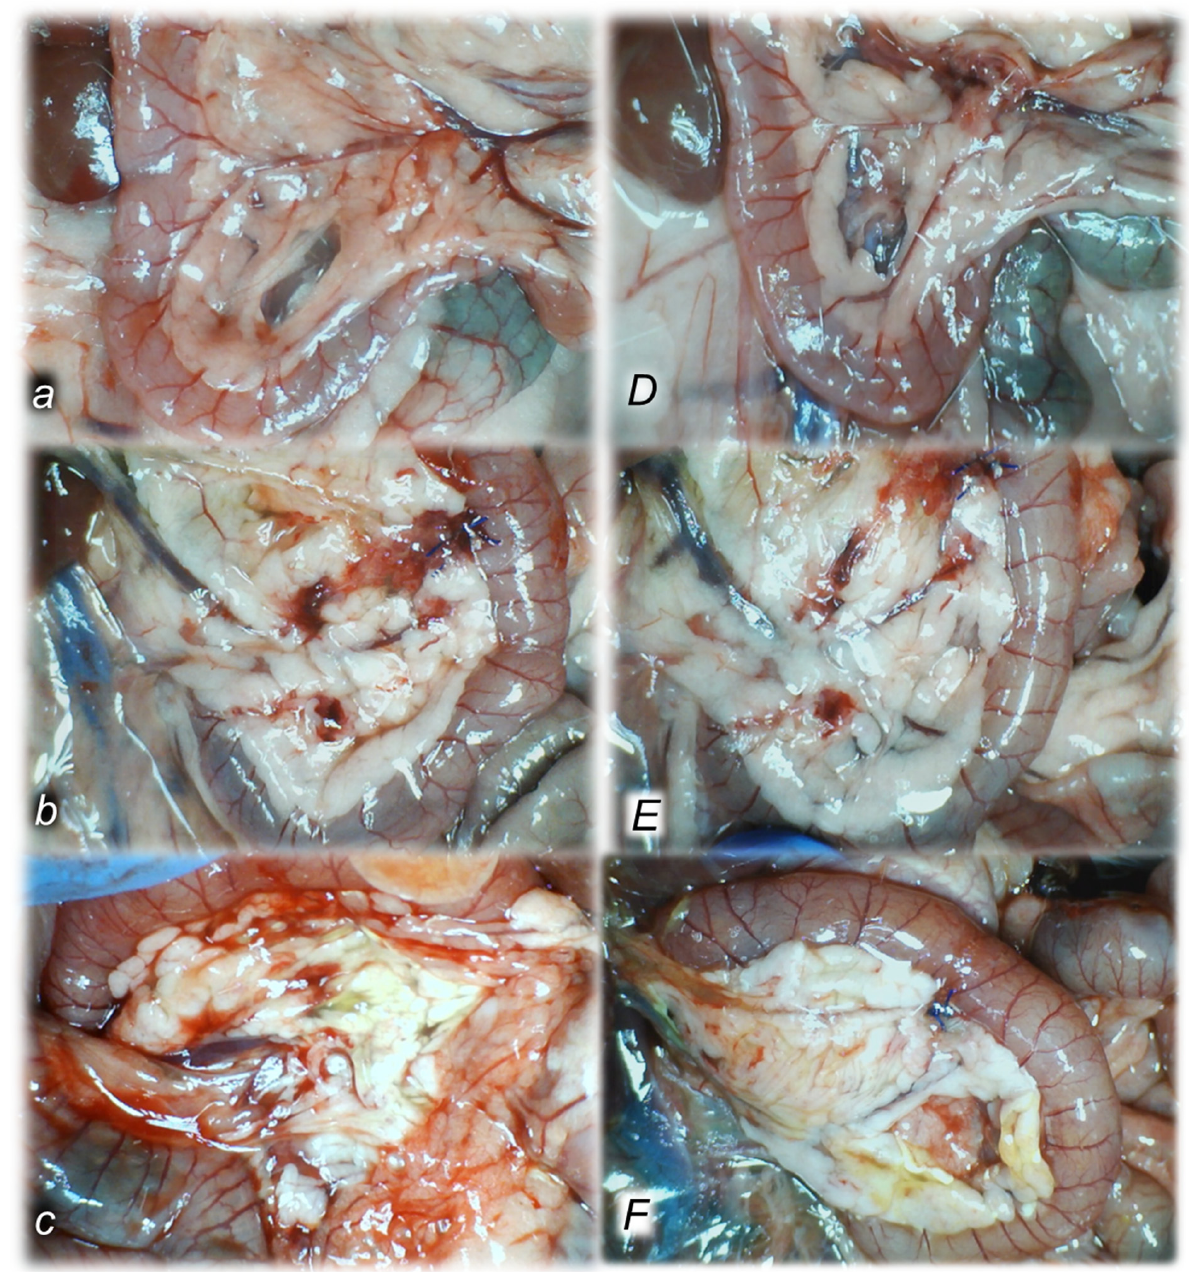
Figure 5. Regular timeline (30 min ( a , D ), 5 h ( b , E ) and 24 h ( c , F ) ligation time period) of disturbed pancreas presentation in controls ( a – c ). Upon BPC 157 therapy and recruitment of the defensive pathways, pancreas swelling and lesions ( D – F ) at 30 min ( D ), 5 h ( E ) and 24 h ( F ) ligation time period were counteracted. Illustrative recovered presentation included BPC 157 (10 ng/kg) or saline (5 mL/kg) as an intragastric administration, either immediately following ligation, as an early regimen (0–30 min ( D ), 0–24 h ( F )), or as delayed regimen (4.30 h–5 h ( E ) application sacrifice